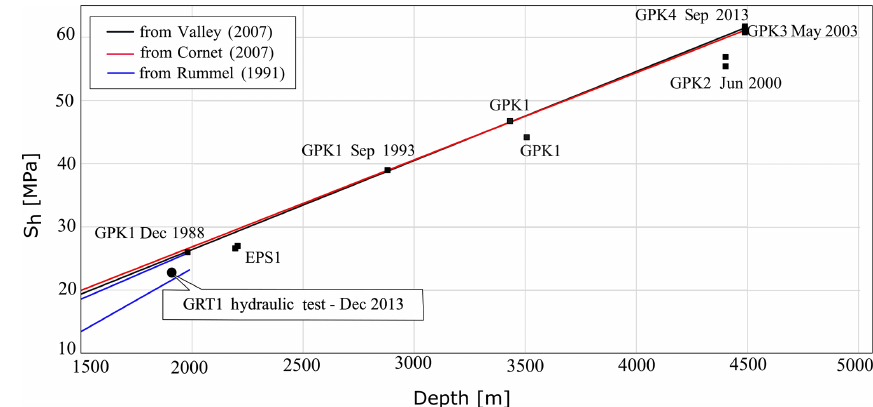
Figure 13. Minimal horizontal stress S h (MPa) as a function of vertical depth (TVD) measured at the Soultz-sous-Forêts site from the analysis of high-volume injections in the GPK-1, GPK-2, GPK-3 and EPS-1 wells. The lower bound for the minimal horizontal stress S h obtained from the analysis of the wellhead pressure measured during the stimulation of well GRT-1 in Rittershoffen is represented for comparison as a black circle.